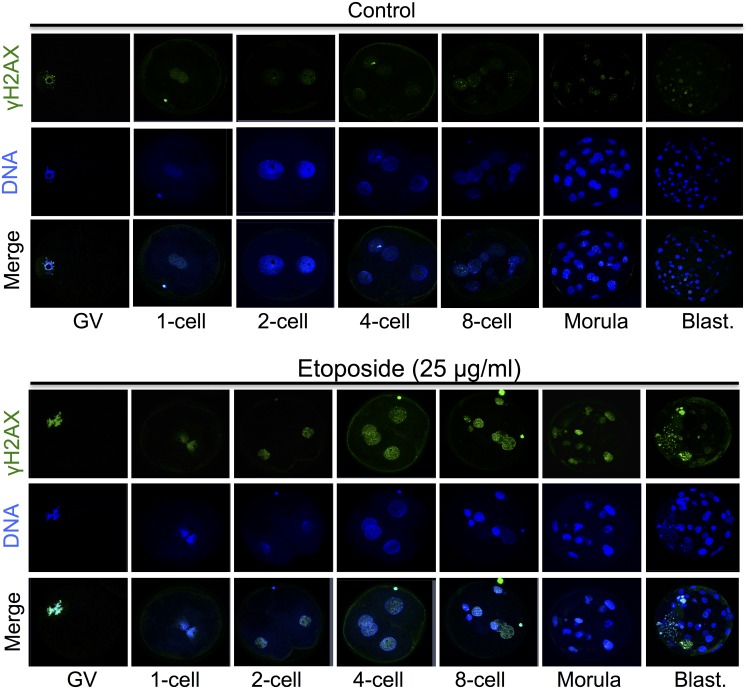
Treatment with 25 μg/mL etoposide for 5 h causes the activation of histone H2AX (γH2AX) at the sites of DNA damage.Representative fluorescent images of oocytes and embryos that were unexposed (control) or exposed to etoposide (25 μg/mL) for 5 h. Cells were immunostained with an antibody against γH2AX. Hoechst was used to stain DNA.